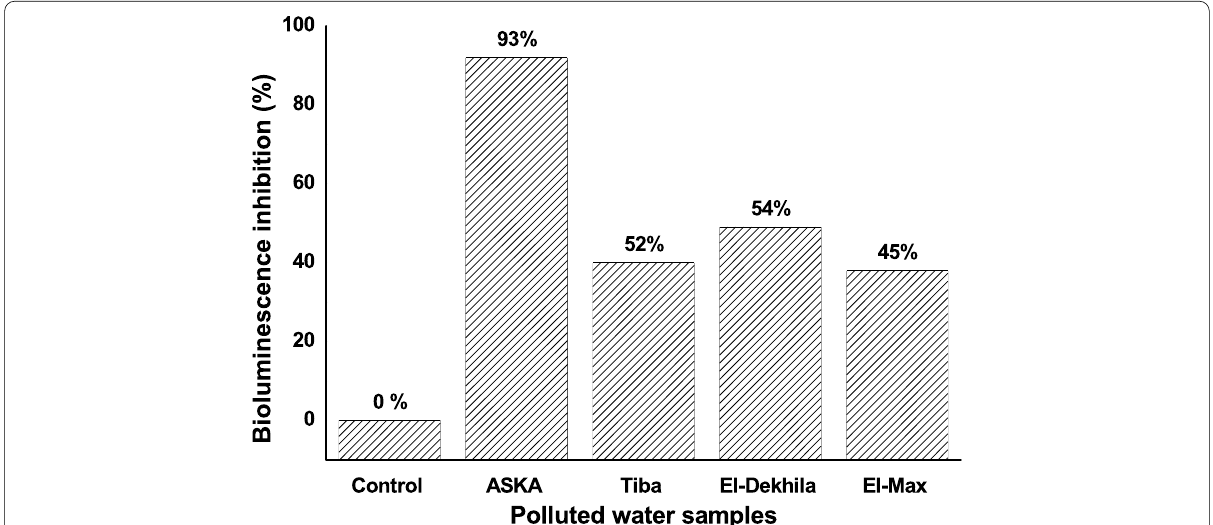
Fig. 11 Effect of different polluted water samples on the bioluminescence of the biosensor Vibrio sp.